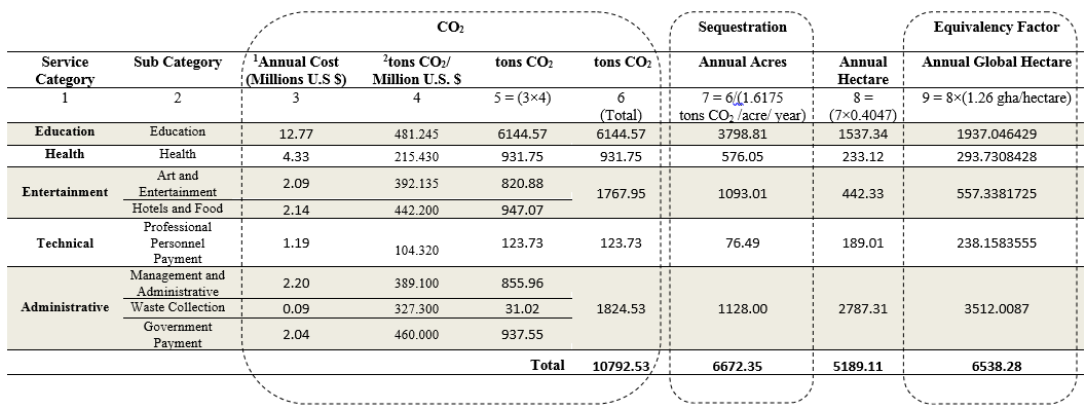
Figure 13. Services consumption footprint calculation and derivation. Source: 1 Household survey of Ward 24 RA (2015); 2 [66]).